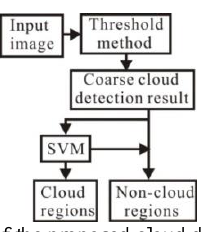
Figure 1. Flowchart of the proposed cloud detection